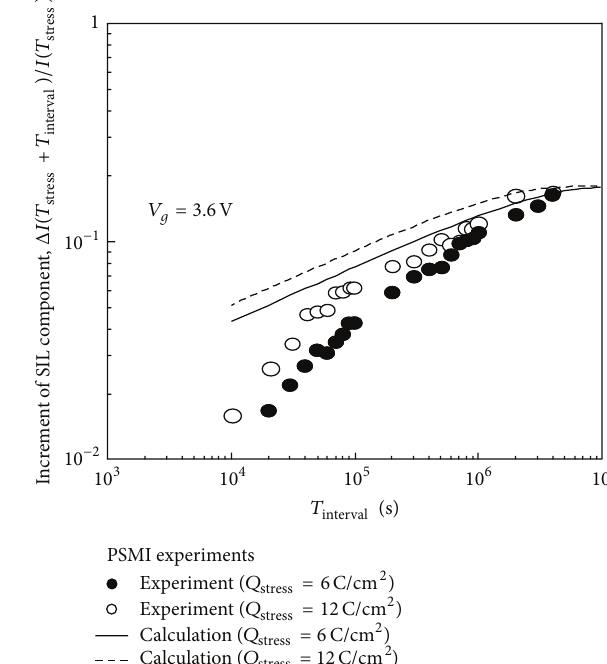
Figure 4: Time evolution of gate current (Δ𝐼(𝑇 (𝑇 )) after a single stress application. Symbols are measured 𝐼 stress stress results, and lines are the results calculated using (2). The CCS condition is 500 mA/cm 2 in all experiments. 𝑄 stress is 6C/cm 2 or 12C/cm 2 .